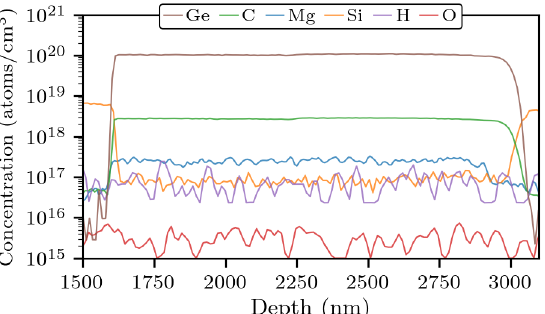
Figure 2. Impurity concentrations in Sample B , measured by secondary-ion mass spectrometry (SIMS) at EAG Laboratories. The germanium-doped GaN layer is located at depths in the range of 1600–3000nm. The layers above and below are not of interest.